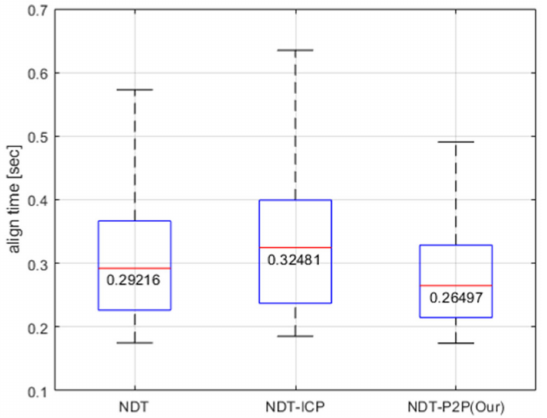
Figure 13. The process time by algorithm in an